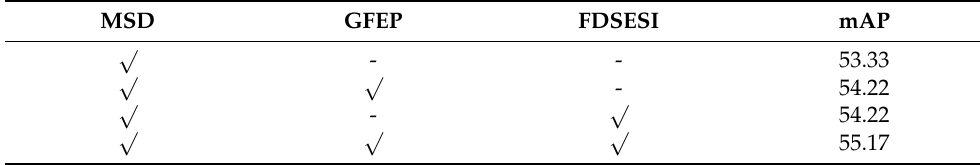
Figure 10. MSD ship detection results applying GFEP and FDSESI based on the SDS dataset. ( a ) Ground truth; ( b ) GFEP; ( c ) Sea, and land segmentation mask overlaid on GFEP; ( d ) Results of applying FDSESI. Table 4. Ablation study based on HRSC2016